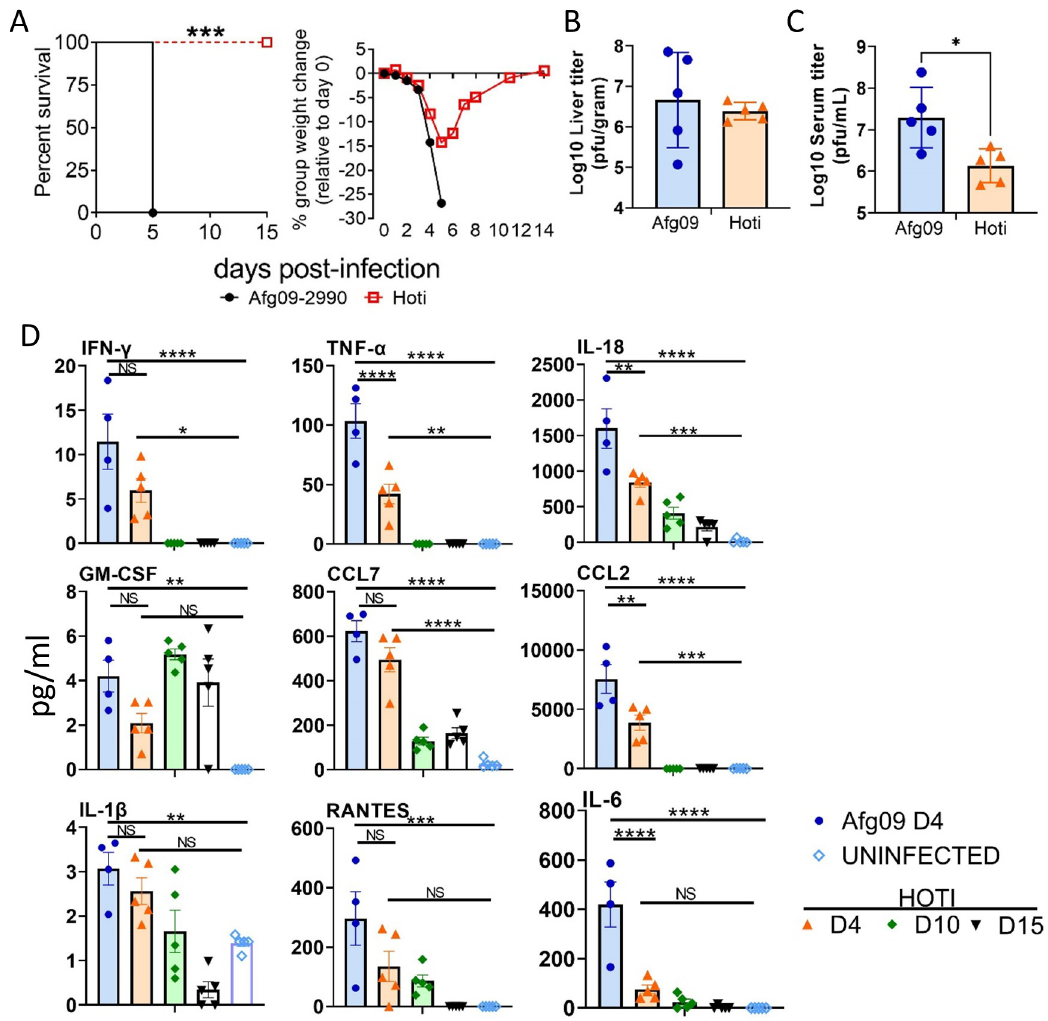
Fig 7. Infection of mice with CCHFV strains Afg09-2990 and Hoti. A. C57BL/6 mice (n = 8 per group) mice were infected with CCHFV strains Afg09-2990 or strain Hoti and injected with MAb-5A3 a day after challenge. Weights and survival were monitored for 15 days post-infection. Significance determined by log-rank analysis; ��� p < 0.0001. B. Liver viral titers were determined on day 4 (n = 5 mice/group) by plaque assay on cell monolayers and plotted as PFU/gram of tissue. C . Viremia on day 4 was determined (n = 5 per group) as in panel B and plotted as PFU/ml. D. Monocyte chemoattractants and inflammatory cytokines were measured from the serum of CCHFV strain Afg09-2990 (day 4), strain Hoti (day 4, 10 and 15) infected mice (n = 5 per group) or